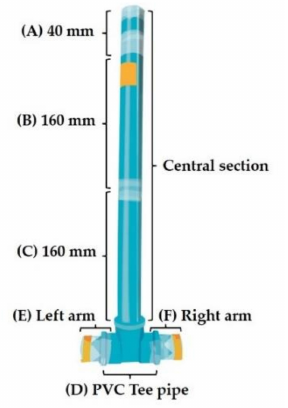
Figure 1. Schematic representation of a modified T-shaped olfactometer. (A) 40 mm PVC piece, (B) and (C) 160 mm length pieces, (D) PVC Tee pipe, and (E,F) left and right arms (40 mm length